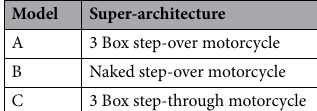
Table 5. Super-architectures of the three